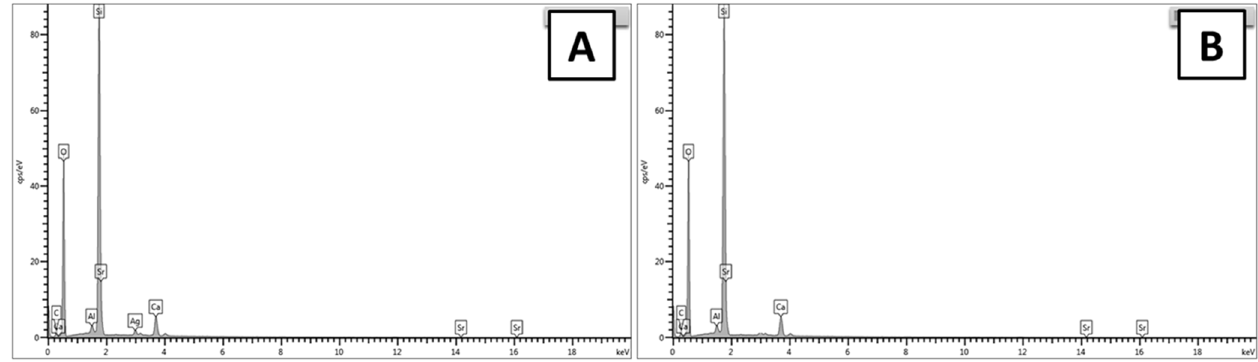
Figure 3. Energy dispersive X-ray (EDX) analysis of the synthesized particles: ( A ) Ag-Sr MBGNs and ( B )